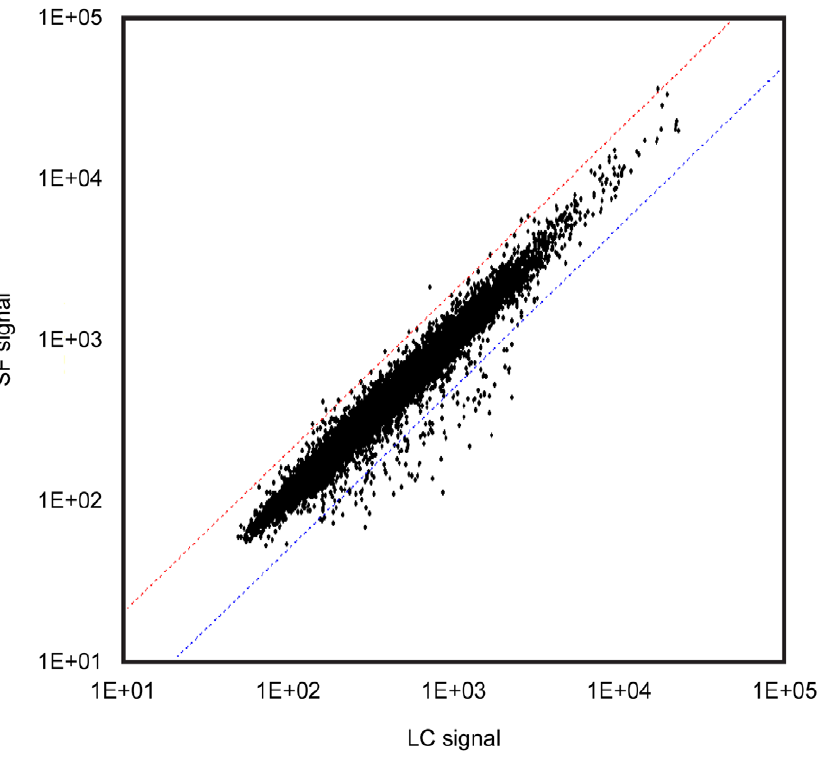
Figure 4. Scatter plots showing the relationship of gene expression between group LC and SF. The dots above and below the dotted slanted lines show the genes in group SF up- and down-regulated, more than 2 folds and/or less than half, vs. those in group GC, according to SAM analysis. See Figure 1 for the abbreviations.